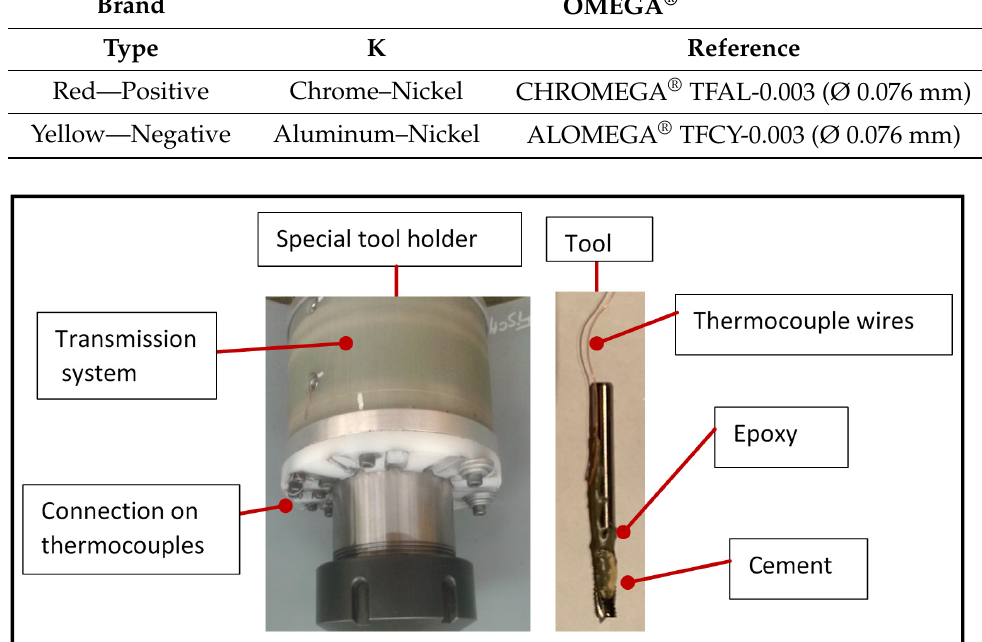
Figure 3. Schematic of cutting temperature measurement system. (Tool holder and tool with thermocouples). Table 3. Characteristics of thermocouples.